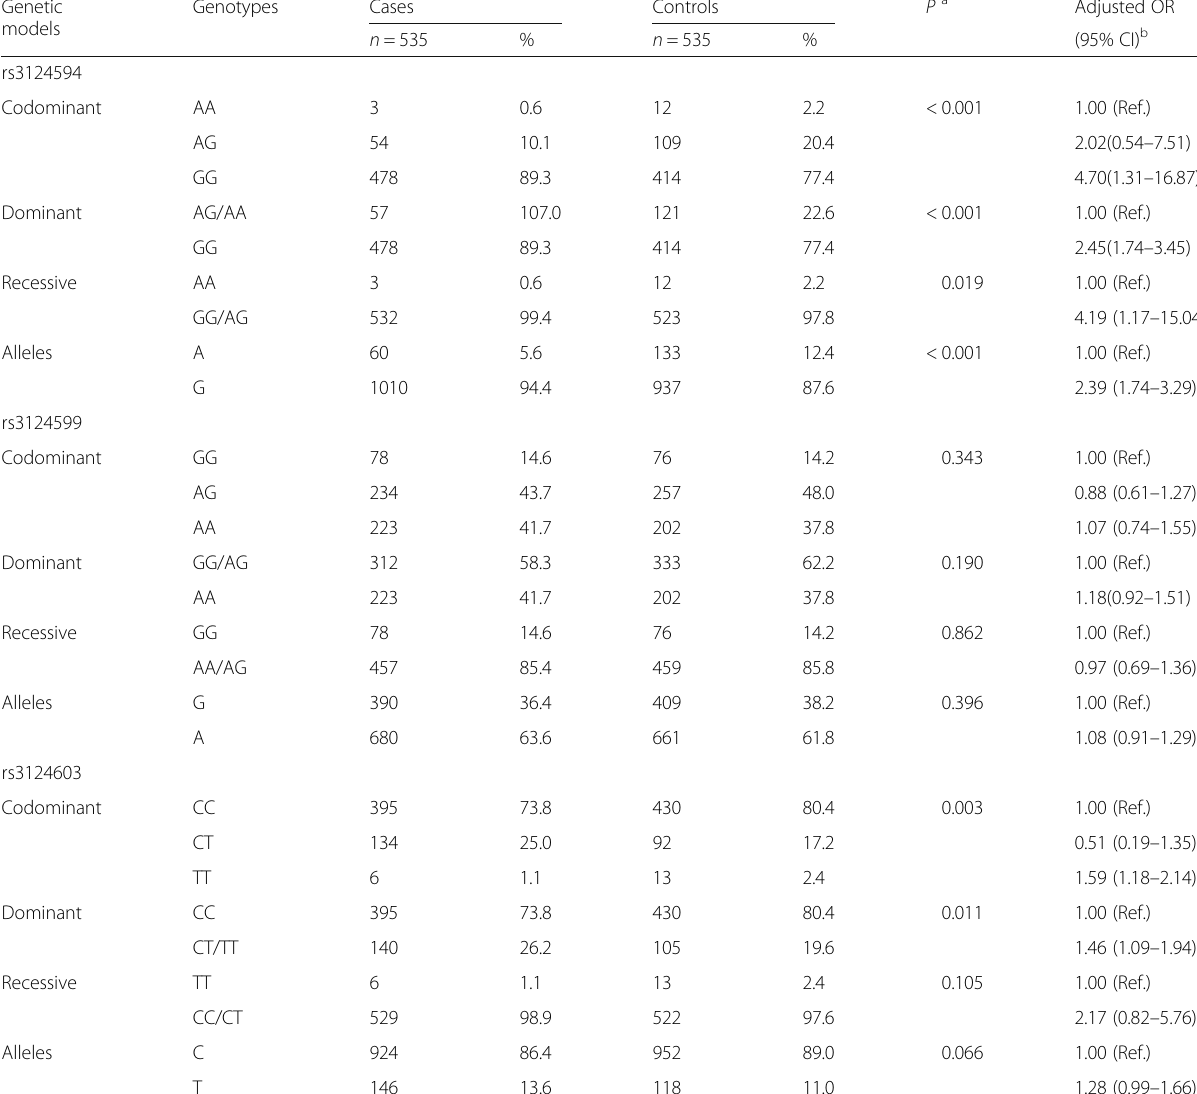
Table 3 Distribution of three polymorphisms and the association with NIHL Genetic models